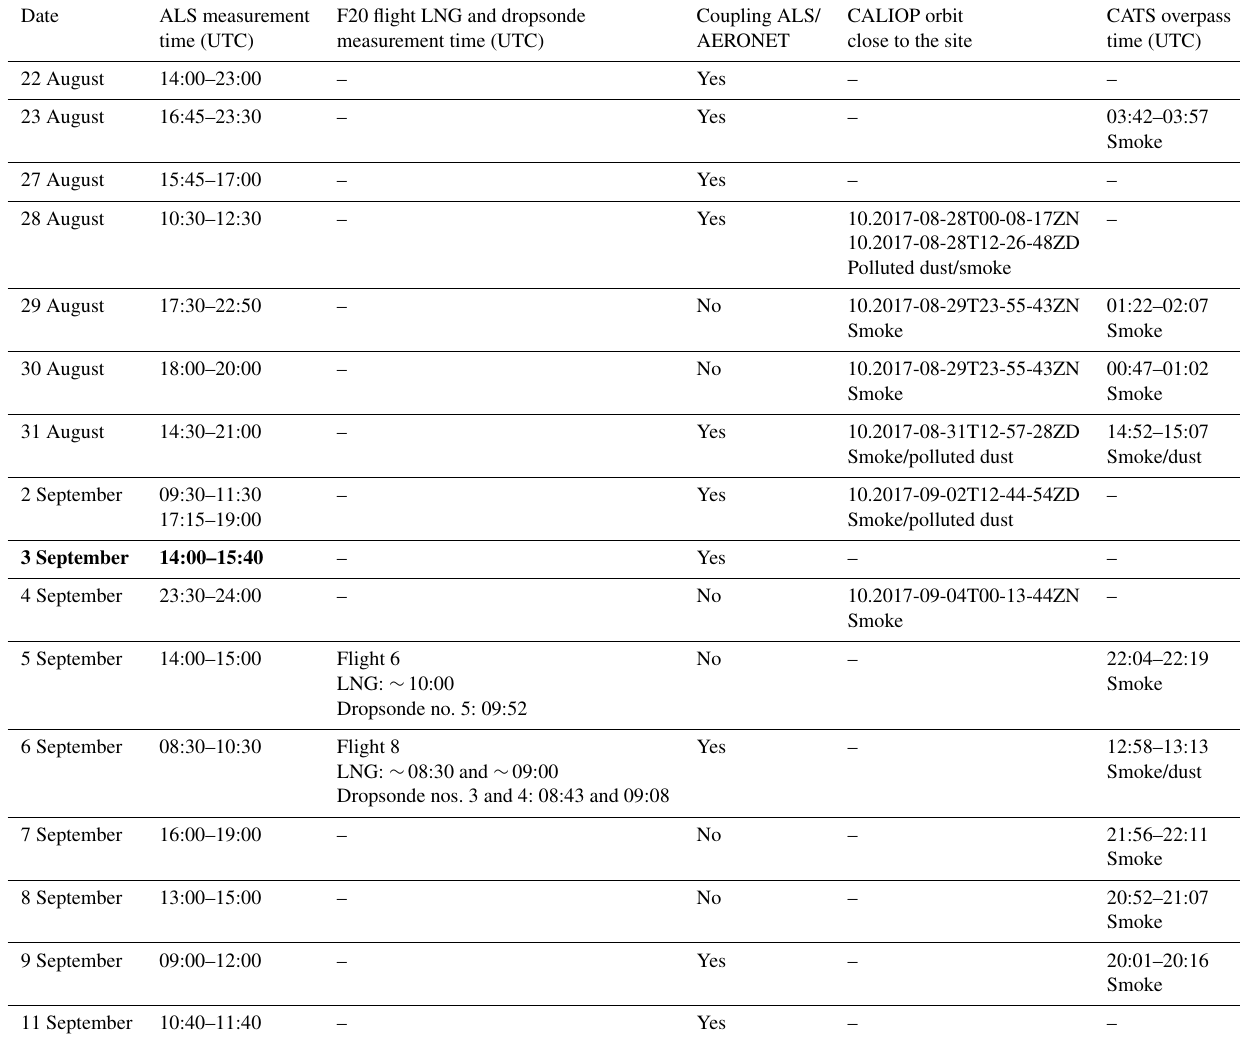
Table 1. Data available during the field campaign for August and September 2017 from the ground-based ALS lidar and AERONET Sun photometer in Henties Bay, the airborne LNG lidar, dropsonde released from the Falcon 20, as well as the CATS and CALIOP space-borne lidars. The line highlighted in bold indicates when the AERONET inversion allows the retrieval of a relevant value for the lidar ratio (level-2 data). The aerosol types as provided by CALIOP and CATS are also indicated for overpasses in the vicinity of Henties